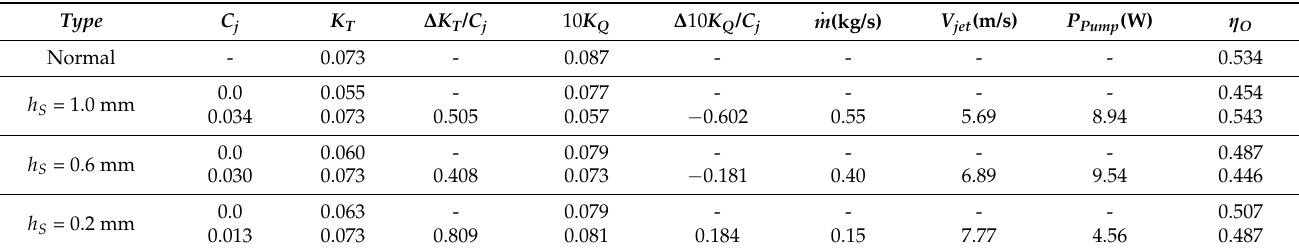
Table 7. Performance comparison of Coanda propeller with thrust identify of normal propeller (NACA66 (MOD, t/c = 0.24)).